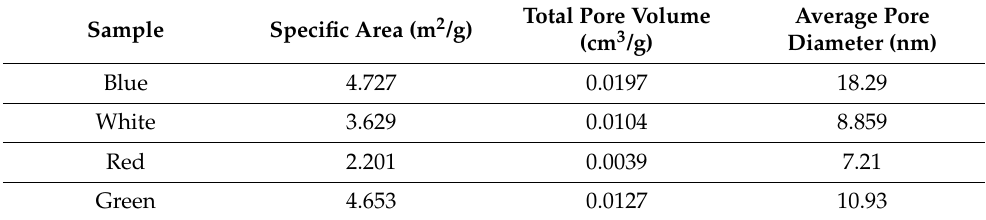
Table 3. Porosity data for the investigated samples.